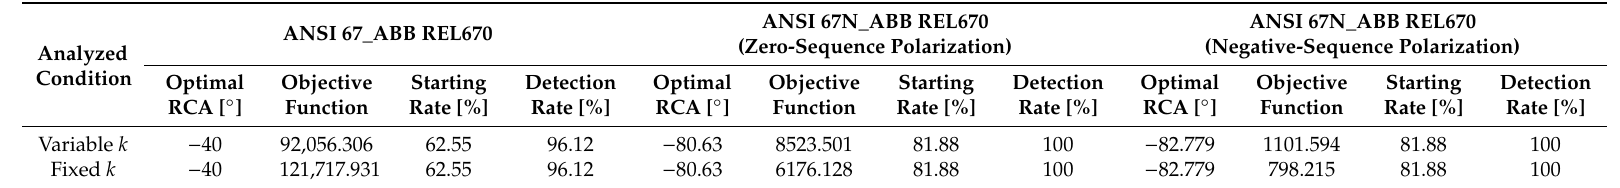
Table 6. Obtained results for the REL670 relay at LT_1 SE_B and optimal